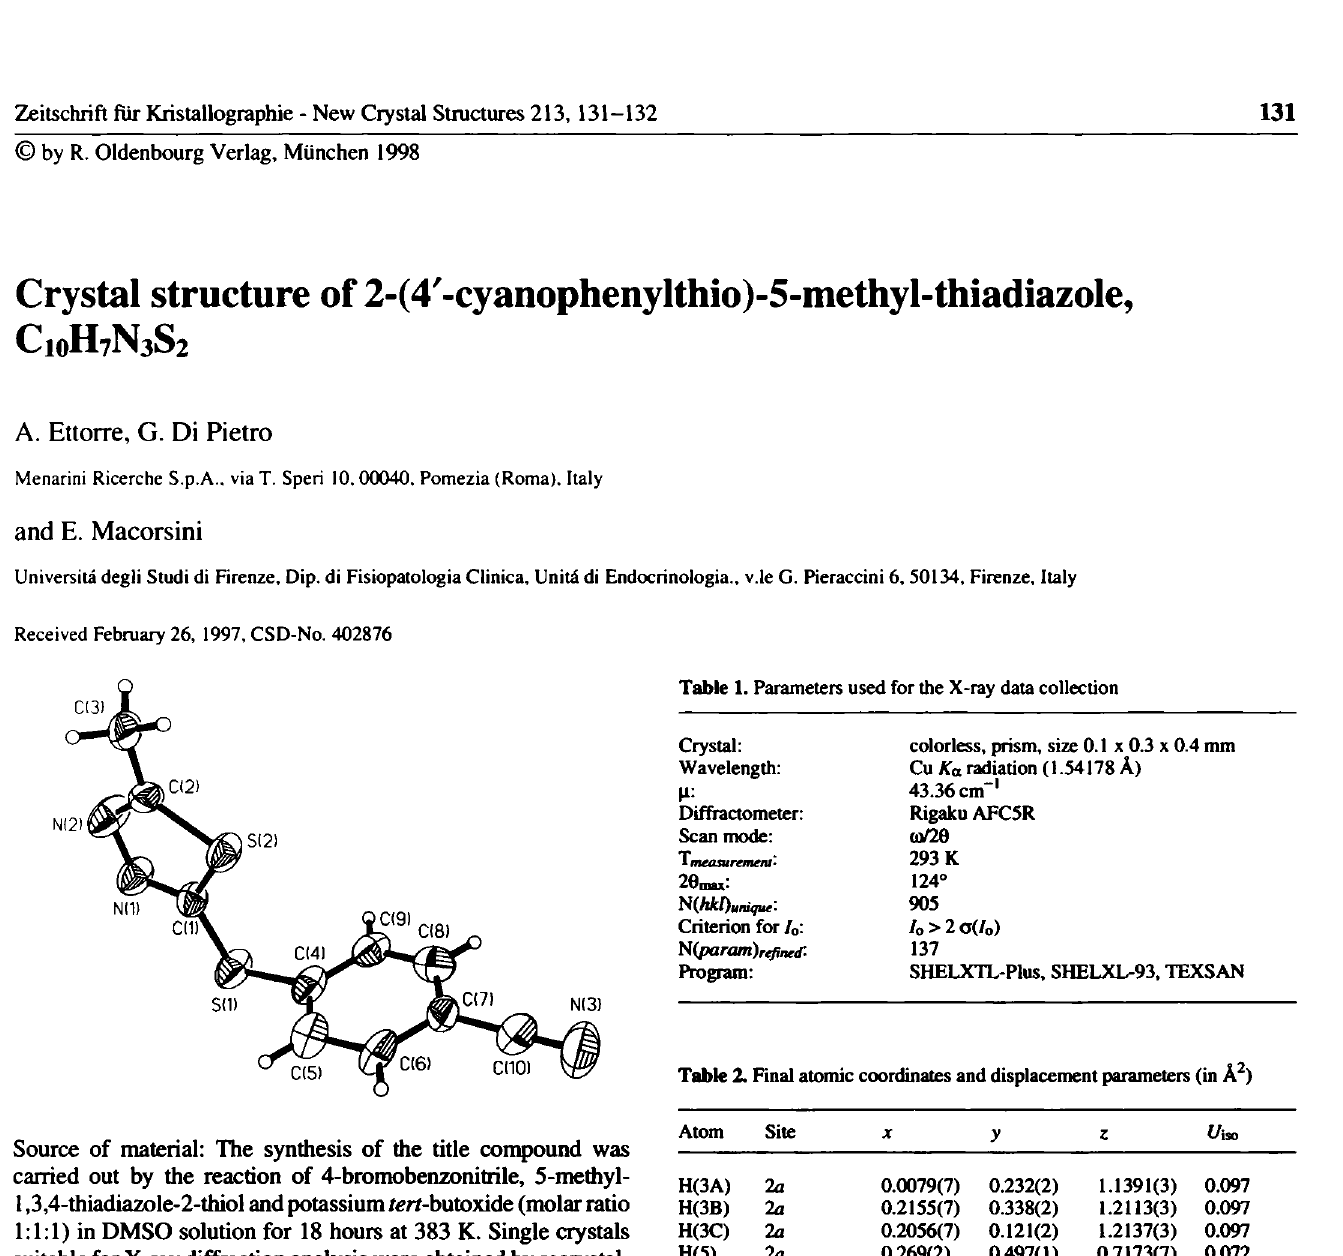
Table 1. Parameters used for the X-ray data collection